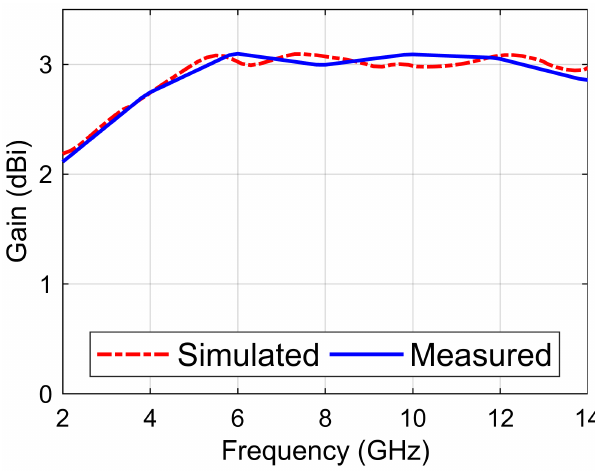
FIGURE 11. Simulated and measured normalized radiation patterns in xz (left) and yz (right) planes at: (a) 4 GHz, (b) 8 GHz, (c) 12 GHz.